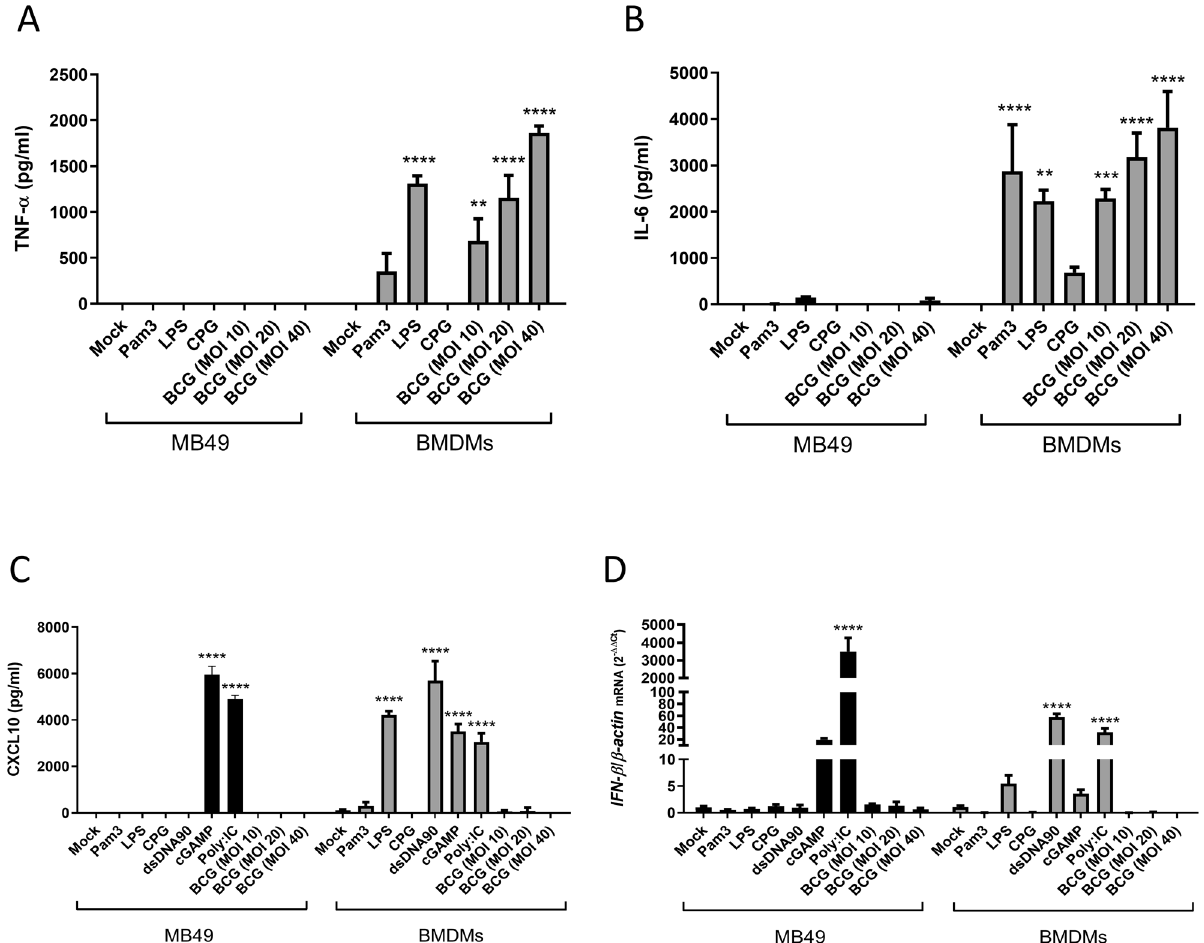
Figure 2. Activation of several innate immune pathways is impaired in MB49 cells. MB49 tumor cells and bone marrow-derived macrophages (BMDMs) were stimulated with Pam3CSK4 (1 µg/ml), ultrapure LPS (100 ng/ml), CpG-ODN (1 µg/ml) or BCG (MOI 10, 20 or 40). MB49 and BMDM cells were transfected with PolyI:C (3 µg/ml), dsDNA90 (3 µg/ml) or cGAMP (6 µg/ml) in addition to Lipofectamine 2000 (3ug/ml). The production of TNF-α ( A ), IL-6 ( B ) and CXCL10 ( C ) in cell supernatants was analyzed after 24 h of stimulus by ELISA. IFN-β expression after 1 h was determined by qPCR ( D ). All qPCR results were relative to β-actin mRNA as a normalizer. MB49 unstimulated sample (Mock) or BMDM (Mock) were used as control. The values are representative of at least two independent experiments. *Statistically significant compared to mock from the same cell line, ** P ≤ 0.01, *** P ≤ 0.001, **** P ≤